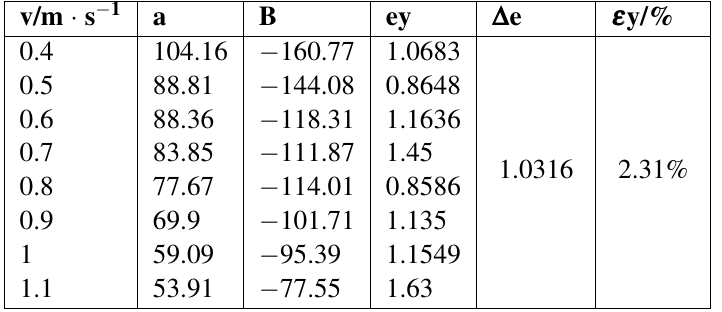
Table 2 Fitting coefficients and errors at different speeds.